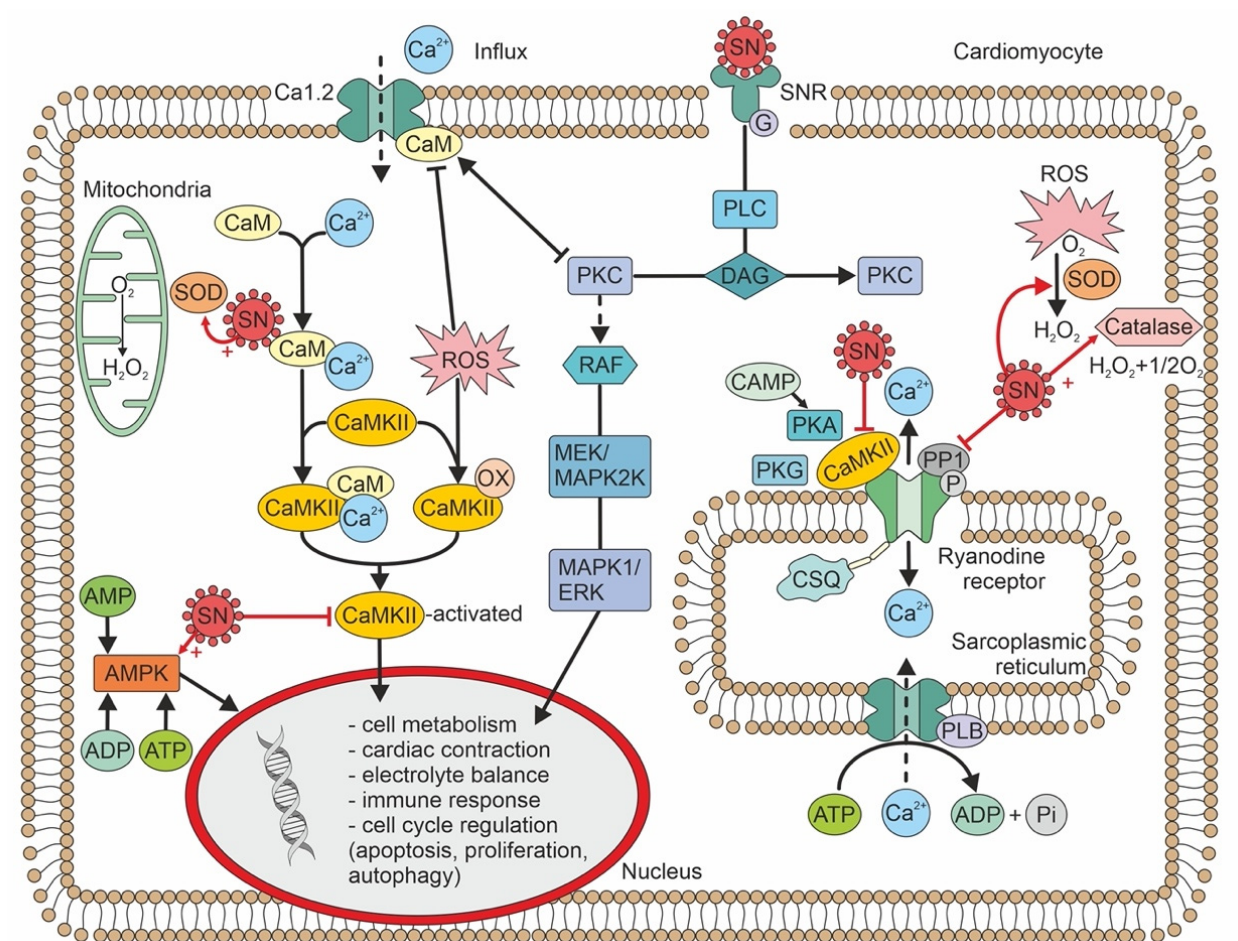
Figure 1. Intracellular signaling pathways of secretoneurin, and biological effects. ADP — adenosine diphosphate; AMP — adenosine monophosphate; AMPK — adenosine monophosphate kinase; ATP — adenosine triphosphate; cAMP — cyclic adenosine monophosphate; CaM — calmodulin; CaMKII — calmodulin-dependent kinase II; CSQ — calsequestrin; DAG — diacylglycerol; ERK — extracellular-regulated kinase; MAPK — mitogen-associated protein kinase; MEK — MAPK/ERK kinase; OX — oxidized; SOD — superoxide dismutase; PLB — phospholamban; P — phosphorus ; PKA — protein kinase A; PKC — protein kinase C; PKG — protein kinase G; PLC -phospholipase C; RAF — serine-threonine protein kinase; ROS — reactive oxygen species; SN — secretoneurin; SNR — secretoneurin receptor.